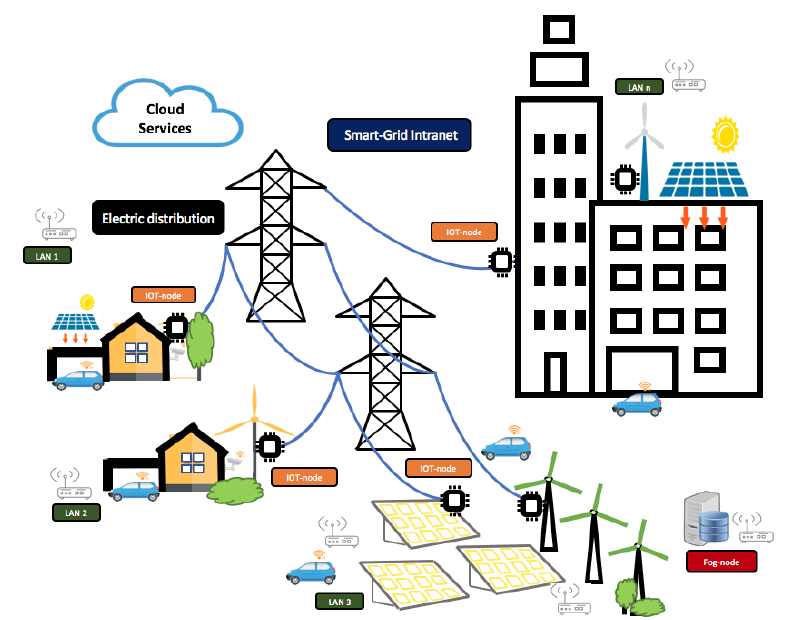
Figure 1. Model scenario proposed. Different sources of renewable energy, buildings, and housing are organized in a management layer (smart grid intranet). IoT nodes, smart grid layer, electric distribution control, and cloud services are the items